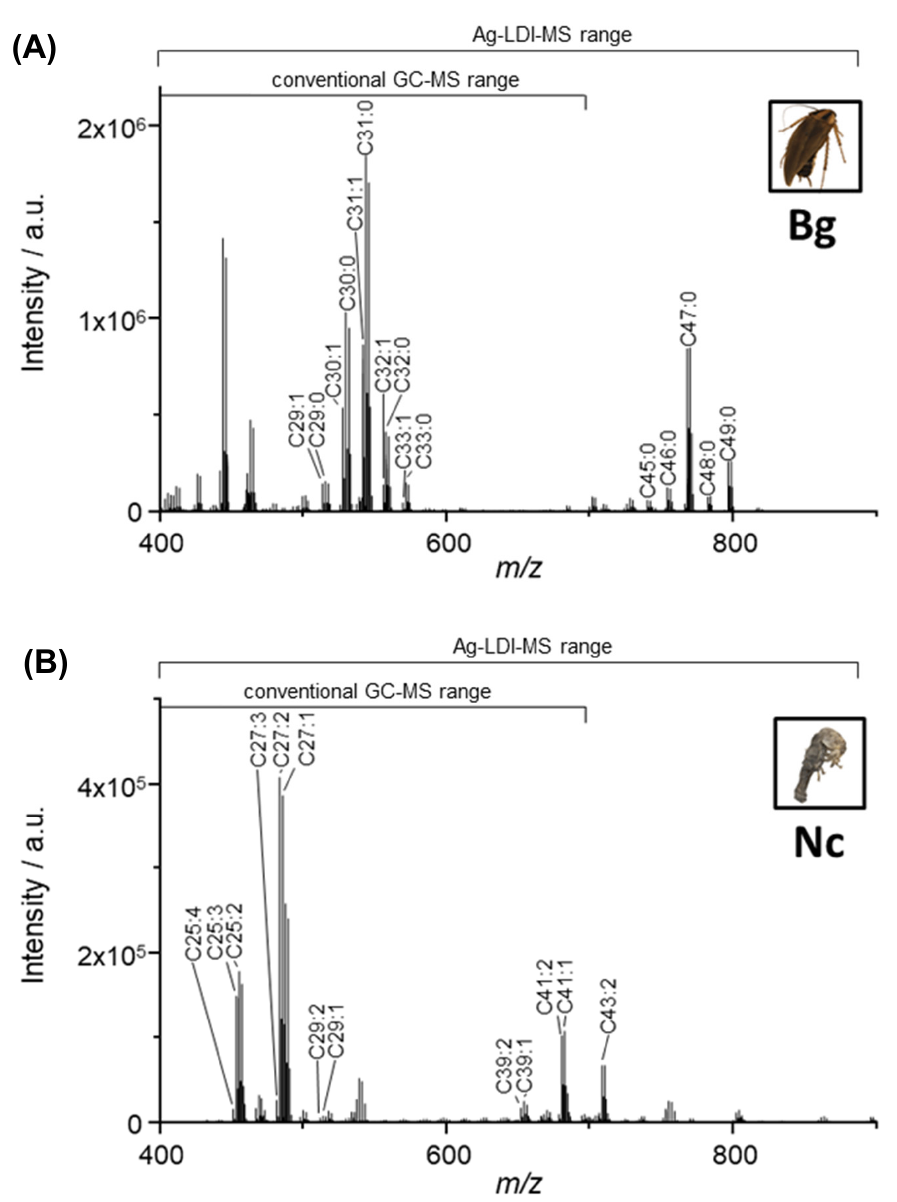
Figure 1. Ag-LDI mass spectra of heptane extracts from ( A ) a single B. germanica (Bg) and ( B ) a pool of three N. castaneus (Nc). All CHCs are detected as [M+ 107 Ag] + / [M+ 109 Ag] + doublets. Major ion signals are annotated with their putative identities as [M+ 107 Ag] + -adducts based on the exact mass measurement with a mass accuracy of <5 ppm. The chain length range simultaneously accessible by conventional GC-MS is indicated to contrast it with the wider chain length range detectable by Ag-LDI-MS. Insect images have been obtained from their DISC3D scans (see Figure S1). Ag-LDI mass spectra of the remaining species are shown in Supplementary Figure S2, comparative GC-MS chromatograms in Figure S3.